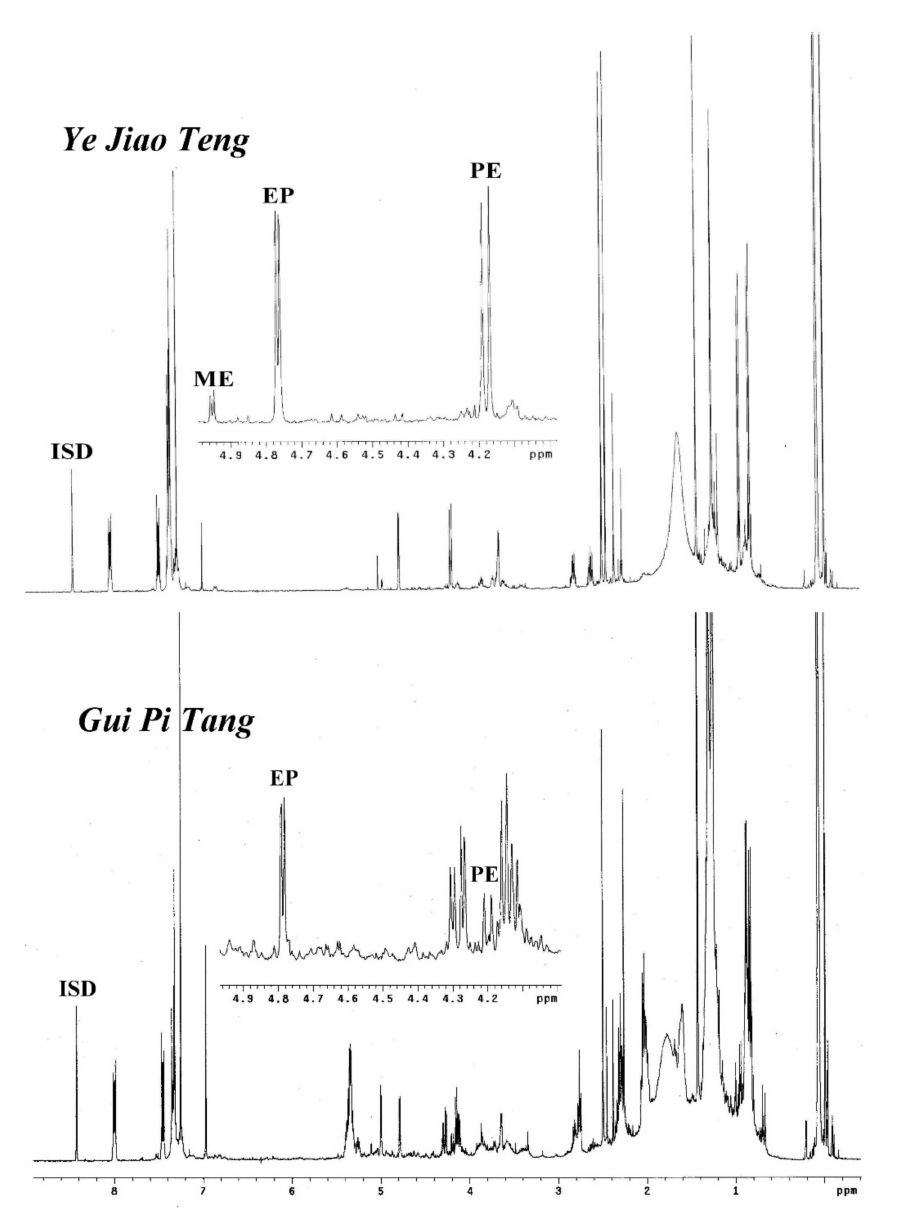
Figure 5. 1 H-NMR spectra of the commercial prescriptions Ye Jiao Teng and Gui Pi Tang from company E. ISD: